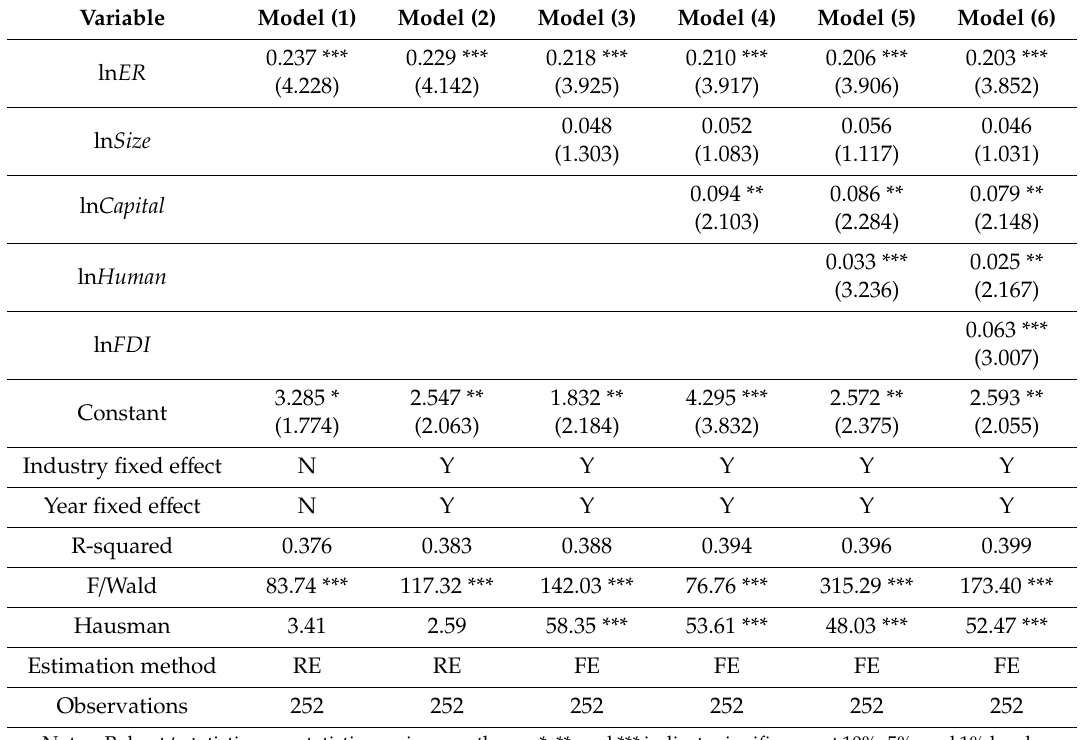
Table 5. Benchmark regression